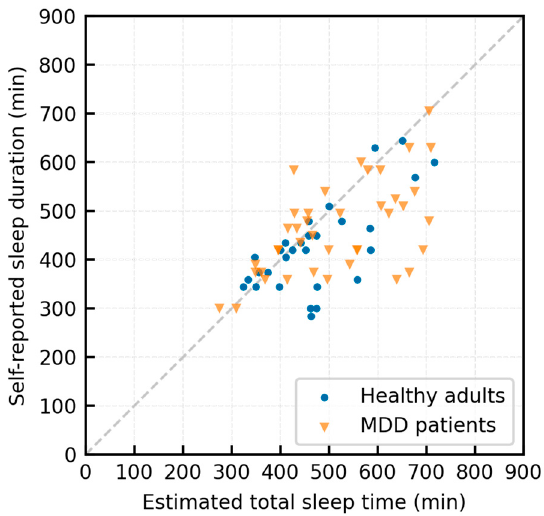
Figure 4. Scatterplot of the estimated total sleep time and self-reported sleep duration (as recorded in log sheets).